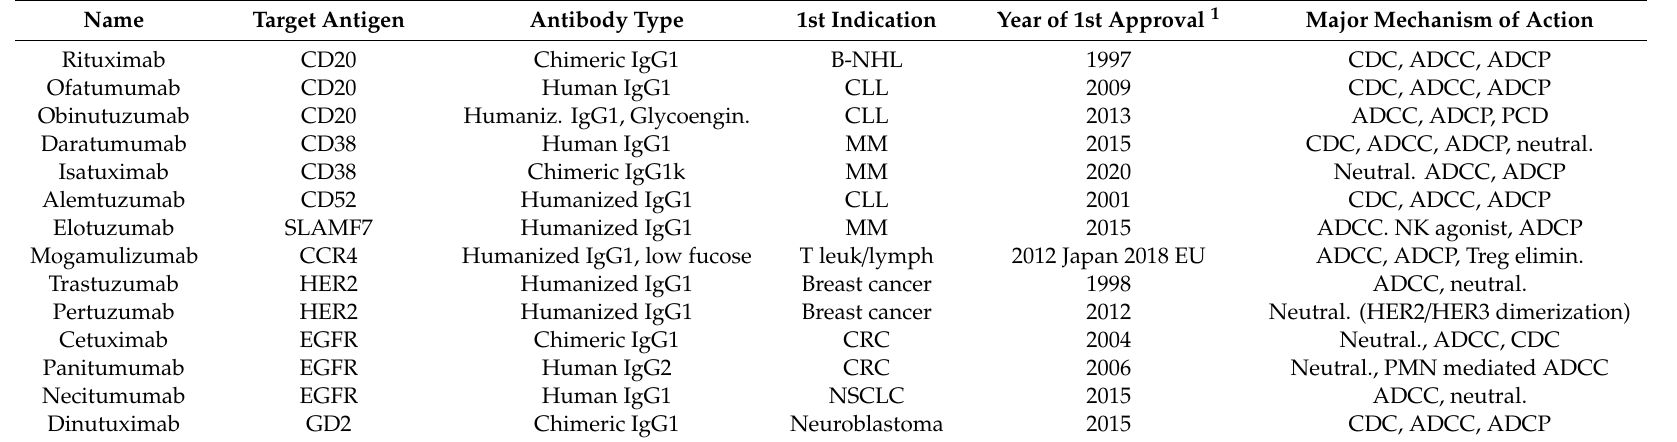
Table 1. Approved unconjugated IgG1 monoclonal antibodies (mAbs) targeting tumor